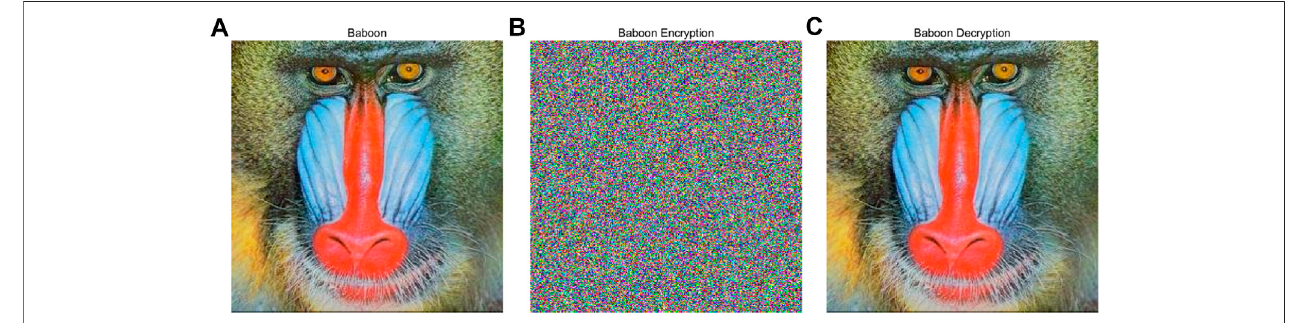
FIGURE 14 | (A) original image; (B) encrypted image; (C) decrypted